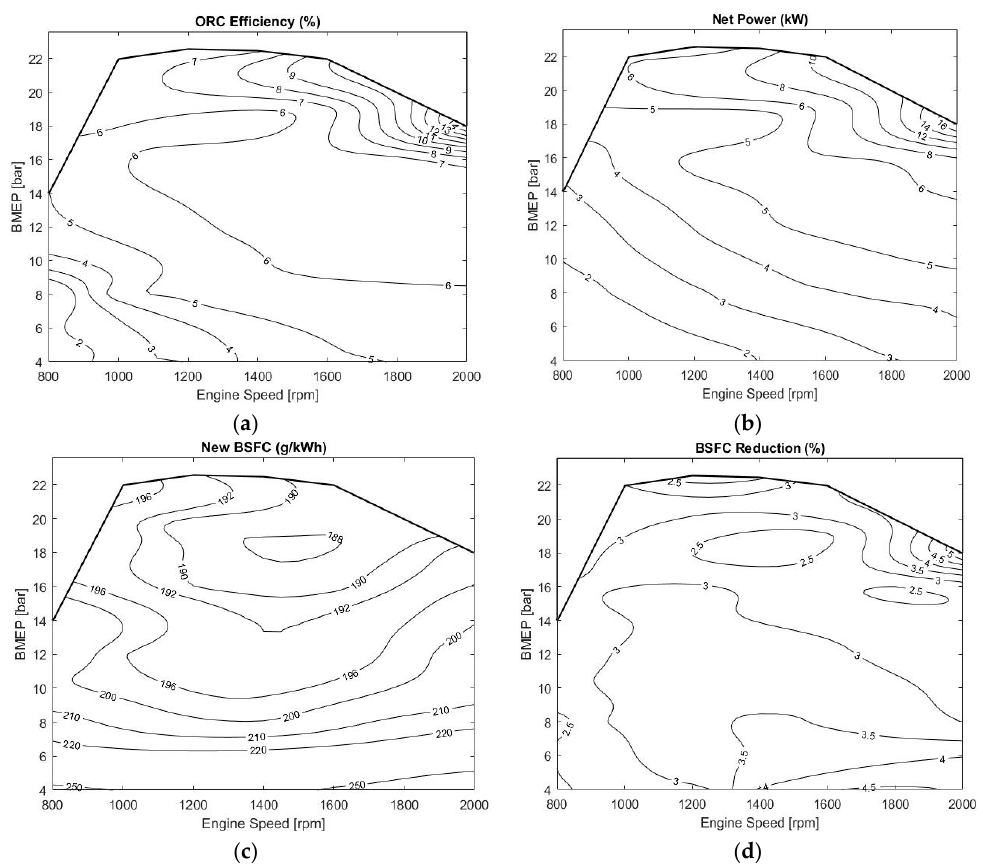
Figure 3. ORC system map of engine: ( a ) ORC efficiency of engine based on BMEP map; ( b ) Net power output of ORC system based on BMEP map; ( c ) New BSFC of engine with ORC based on BMEP map; ( d ) Amount of BSFC reduction in engine with ORC system based on BMEP map.